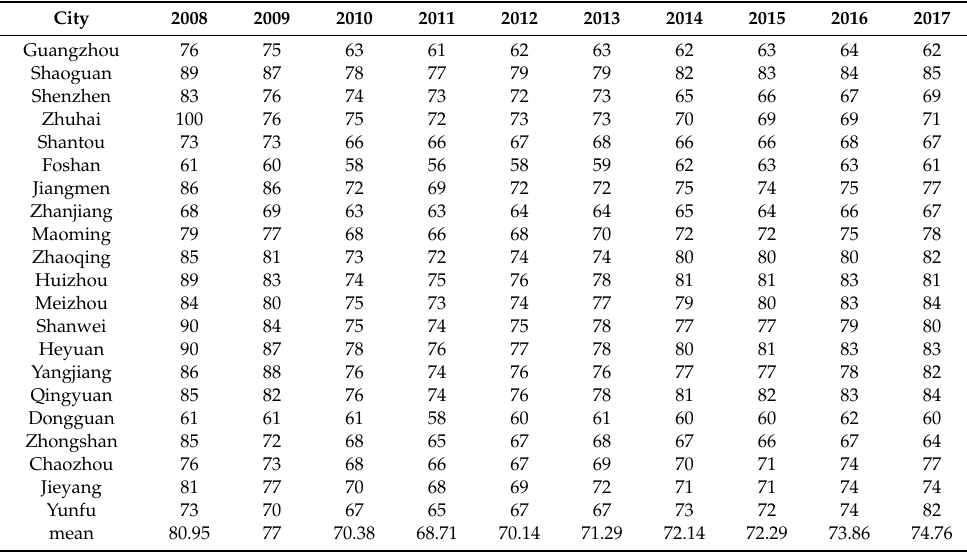
Table 1. Ecological Index (EI) of Guangdong Province in